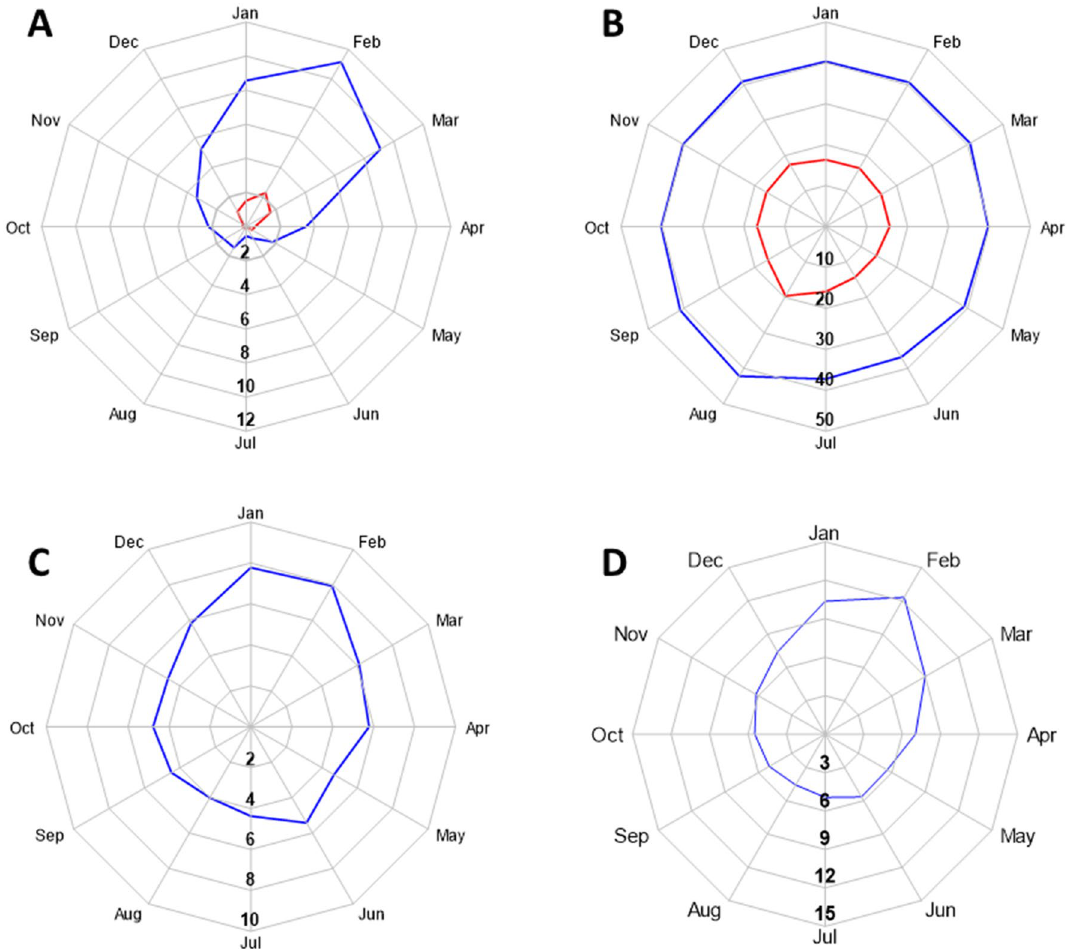
Figure 4. Polar plots of tests and clinical diagnoses performed according to the month of admission. ( A ) Oropharyngeal samples for the influenza virus; ( B ) Bacterial cultures from blood, urine and respiratory secretions; ( C ) Clinical diagnoses of upper respiratory infection, bronchitis or pneumonia; and ( D ) All respiratory infections diagnoses including confirmed influenza infections and influenza-like disease. The blue line represents the percent of cases in each month. The red lines in A and B represent the proportion of positive